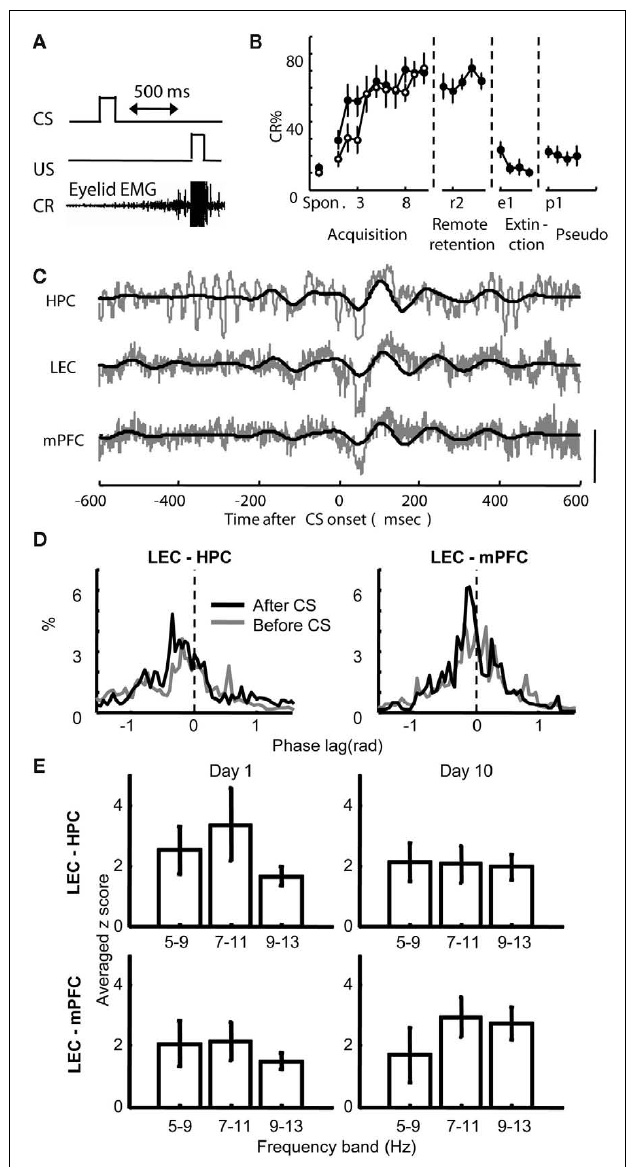
FIGURE 2 | Behavioral performance and theta phase synchronization between the hippocampus (HPC), lateral entorhinal (LEC), and medial prefrontal cortices (mPFC) during trace eyeblink conditioning. (A) An example trial in the trace eyeblink conditioning paradigm. An auditory conditioned stimulus (CS) was paired with eyelid stimulation (US) separated by a 500-ms stimulus-free interval. A conditioned response (CR) was defined as a significant increase in the eyelid electromyogram immediately prior to the US. (B) Percentage of trials in which rats exhibited CRs increased during acquisition sessions (Acquisition group, empty circle, mean ± SEM from six rats), stayed high during remote retention sessions 1month later (Remote retention group closed circle, mean ± SEM from eight rats), and decreased during extinction and pseudo-conditioning sessions (mean ± SEM from six rats from Acquisition or Remote retention group). Spon. indicates spontaneous eyeblink frequency. (C) Traces of simultaneously recorded local field potentials (LFPs) from the HPC, LEC, and mPFC in a rat during the fifth acquisition session. Raw traces are plotted in gray and theta-filtered traces are overlaid in black.Vertical bar ( Continued